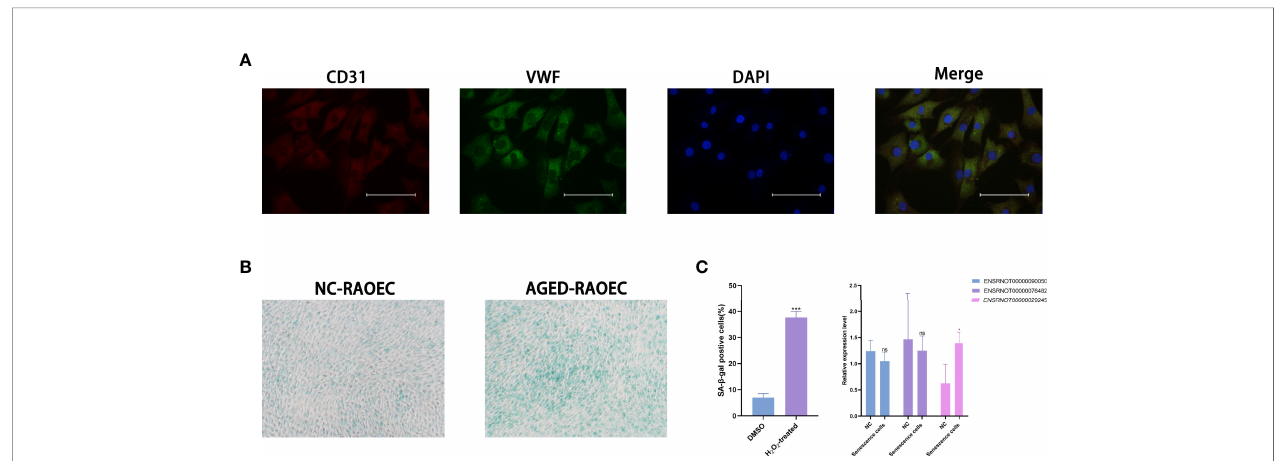
FIGURE 7 | Cell lines validations. (A) Double-immuno fl uorescent staining for biomarkers CD31 and vWF. (B) b -Galactosidase staining for RAOEC cell in the DMSO and the H 2 O 2 treated group. (C) Relative expression of three lncRNAs (ENSRNOT00000090050, ENSRNOT00000076482, and ENSRNOT00000029245) in Senescence cells and NC cells. *P < 0.05. Scale bars = 25 µm.